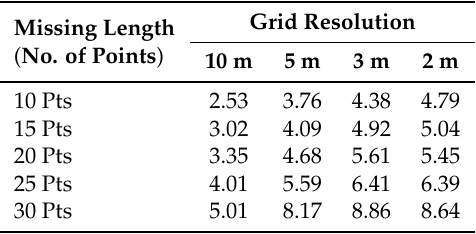
Table 2. ADE loss comparison of methods at different level of grid resolution (10 Pts). Missing Length ( No. of Points